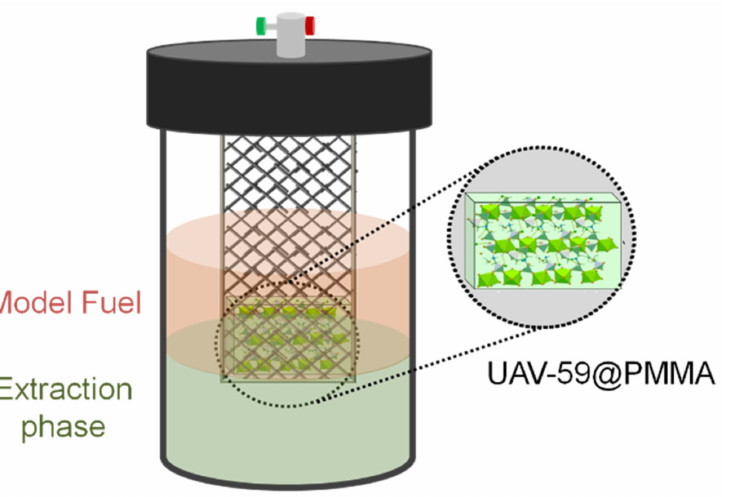
Figure 4. Schematic representation of the extraction and catalytic oxidative desulfurization process and the catalytic membrane